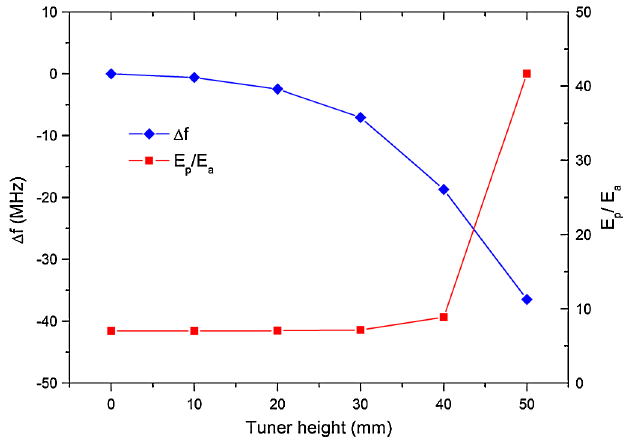
FIG. 13. (Color) Simulated tuning range of ten hypothetic tuners operated in parallel and electrical peak fields appearing at the tuner surface.